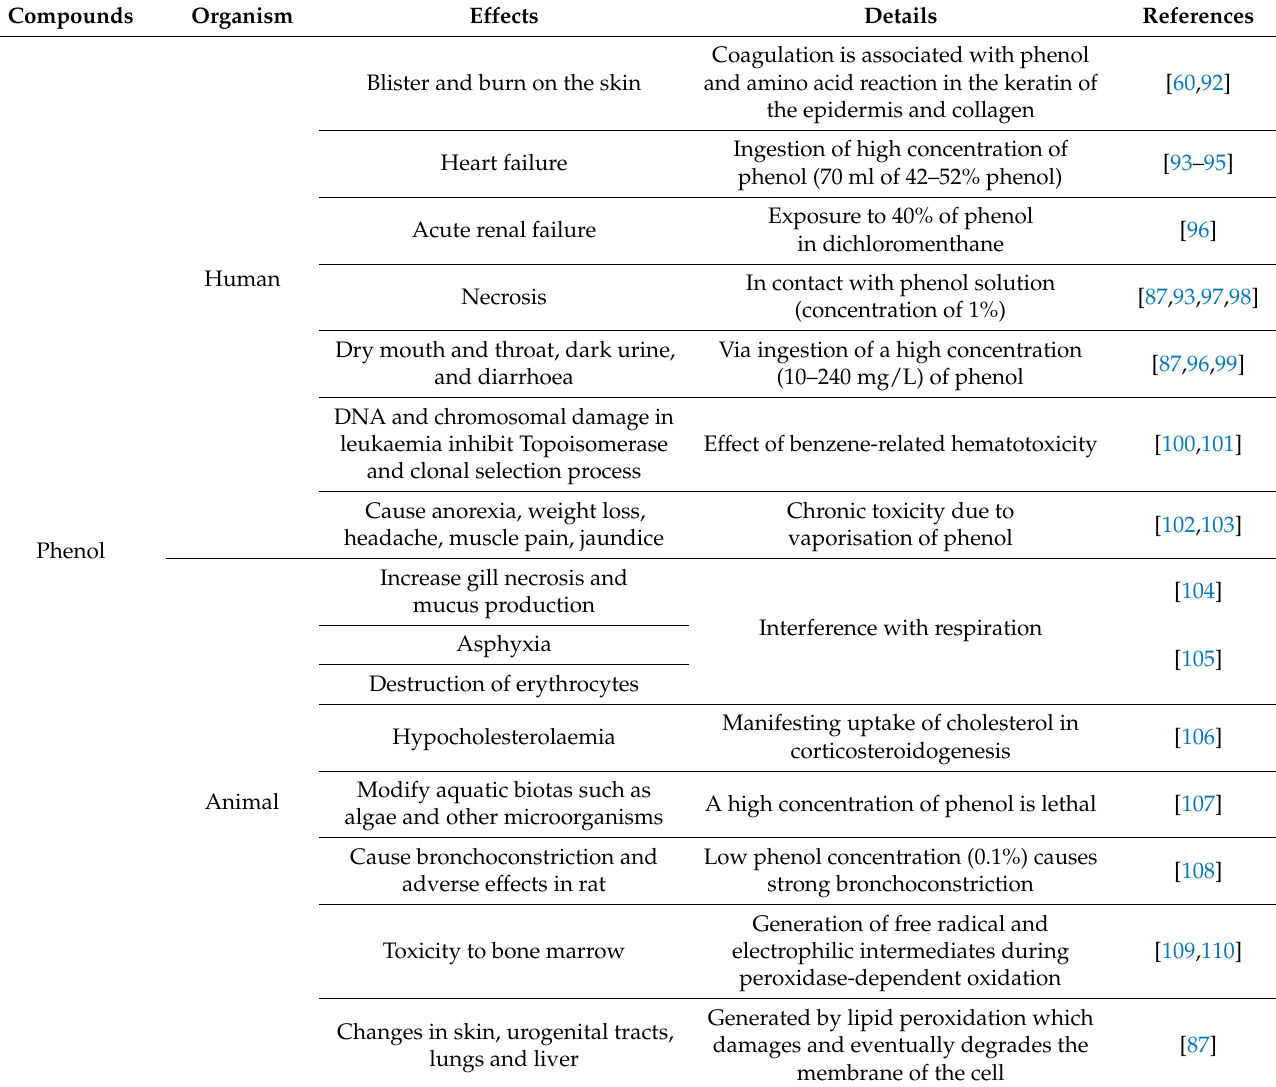
Table 11. The toxicity of phenolic